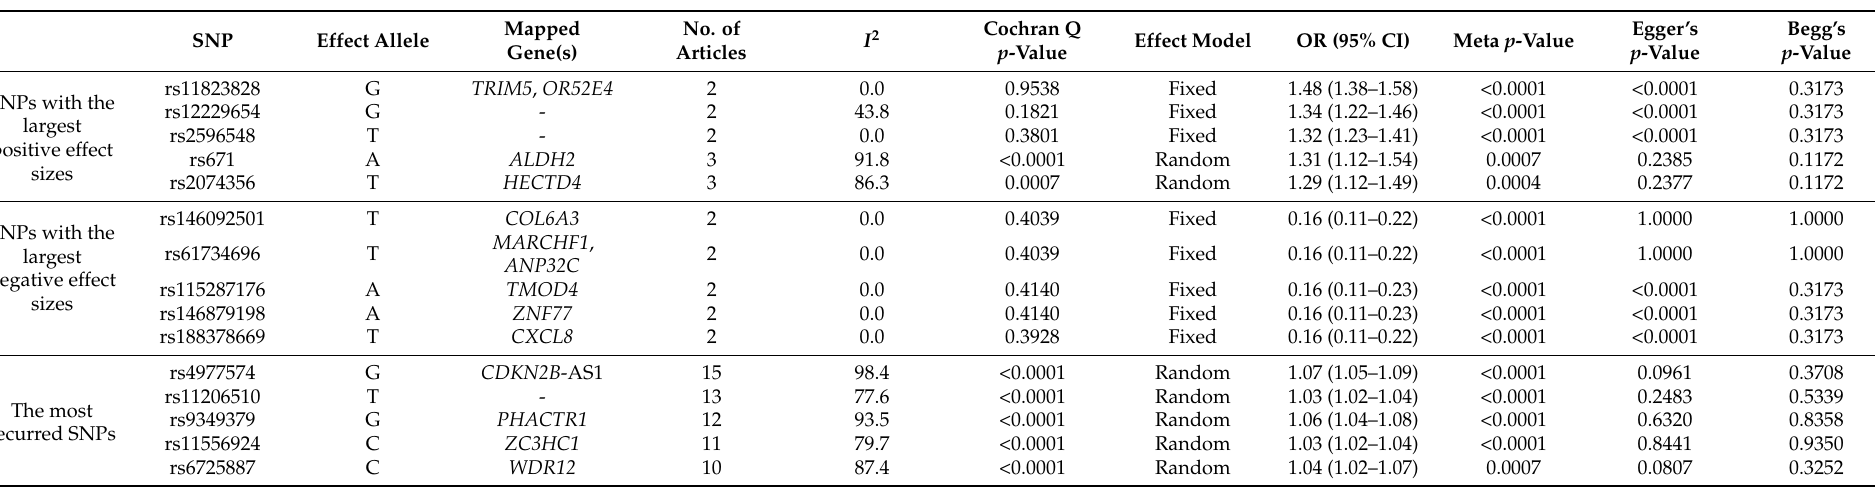
Table 3. Top five single-nucleotide polymorphisms with the largest positive effect sizes, the largest negative effect sizes, and SNPs that recurred the